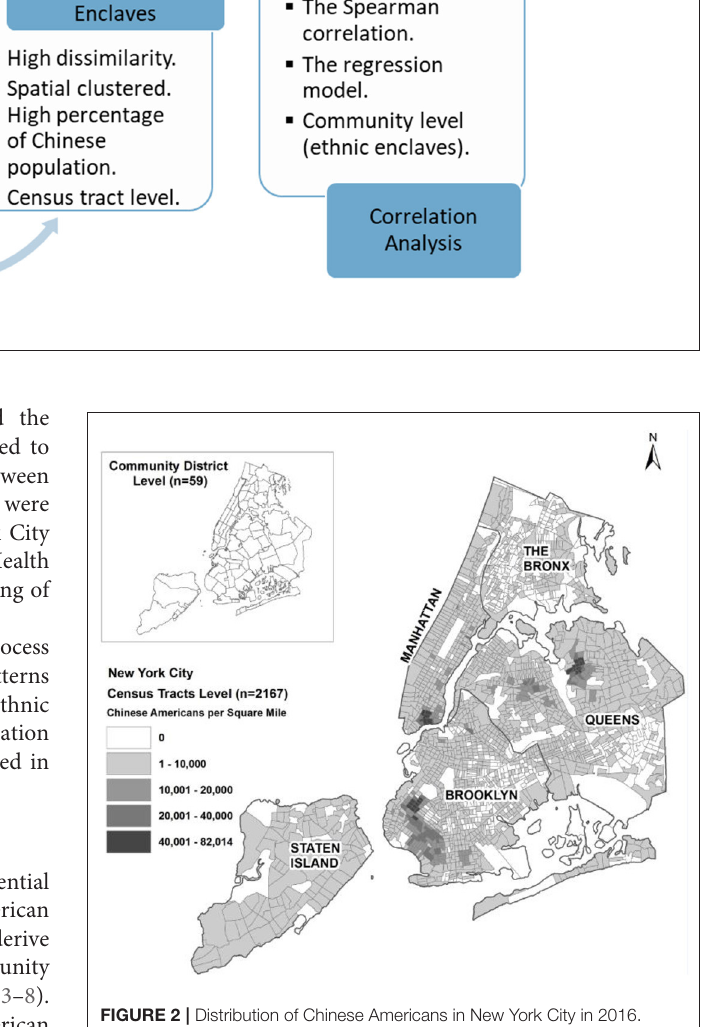
FIGURE 2 | Distribution of Chinese Americans in New York City in 2016. Source: U.S. Census Bureau